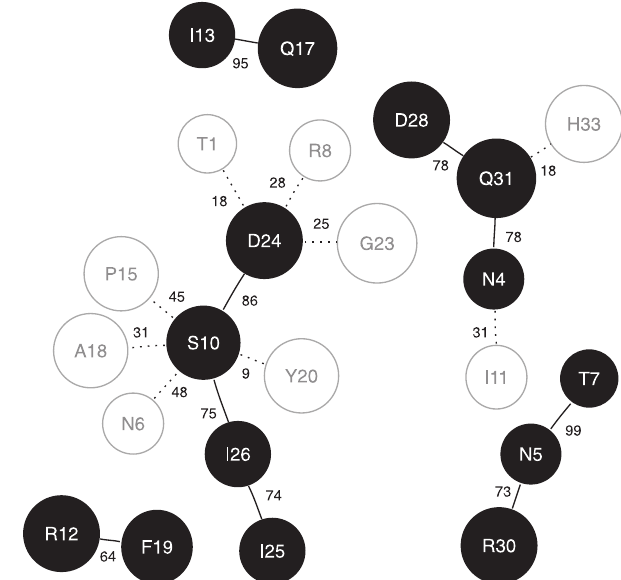
Figure 2. Distribution of the Marginal Posterior Probability of Network Edges This histogram indicates the frequency of the marginal posterior probability of the 528 possible edges, sampled from a Markov chain over the space of node orders (see Materials and Methods). The prior probability of each edge was set to the uninformative value of 0.5. Note that the vertical range of the histogram was truncated to a maximum of 50; the first bin of the histogram contained 485 edges as indicated on the figure. Individual values are indicated by tick marks along the x -axis. A red line indicates the arbitrary cutoff value of 0.95.